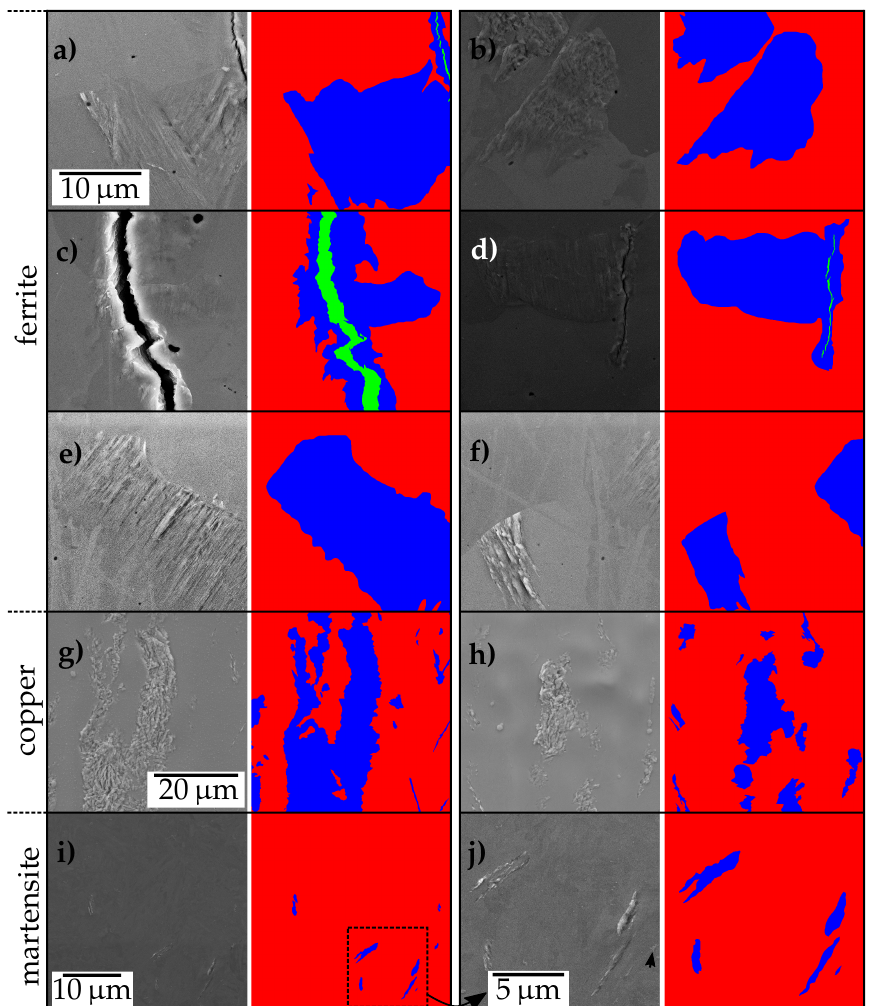
Figure 2. Glimpse at the ferrite ( a – f ), copper ( g , h ) and martensite ( i , j ) extrusion and crack data sets and their corresponding labeling masks. All images from the same material are at the same scale, with the exception of ( j ), which is a magnified view of ( i ). The set of images shows the variable brightness, contrast conditions and extrusion and crack